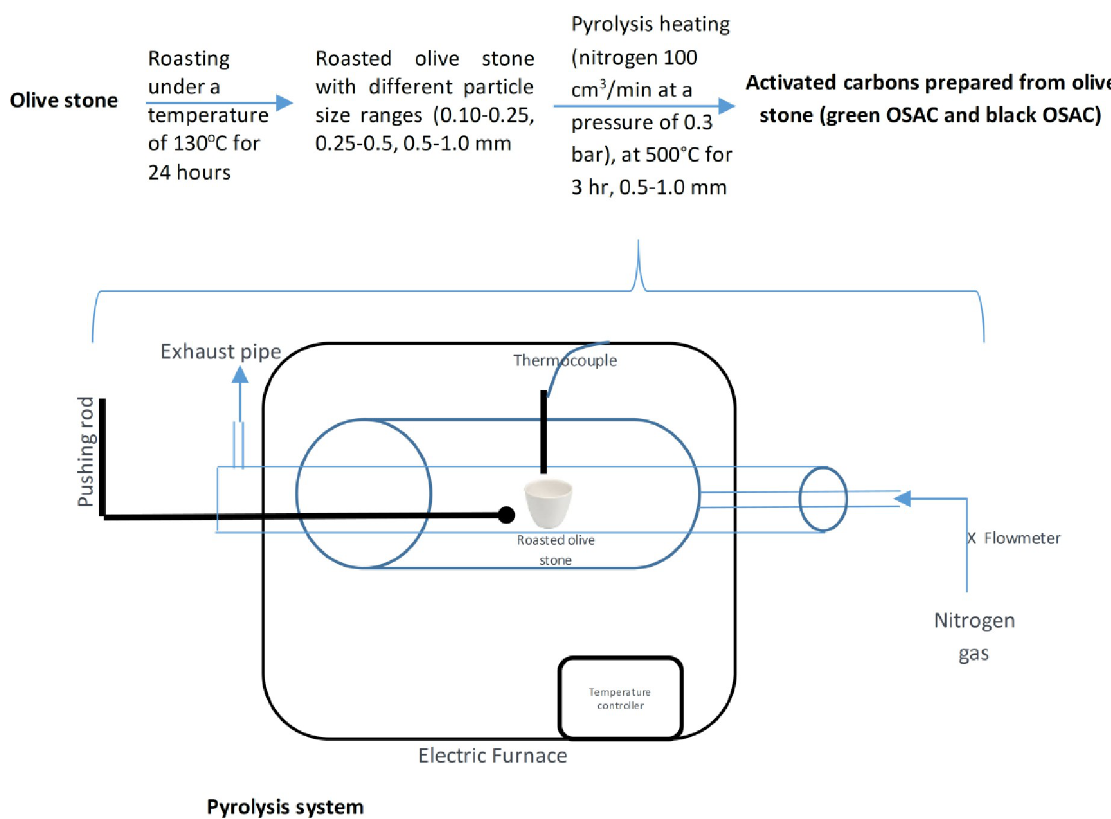
Fig 1. Setup of the OSAC preparation and the pyrolysis system used in the